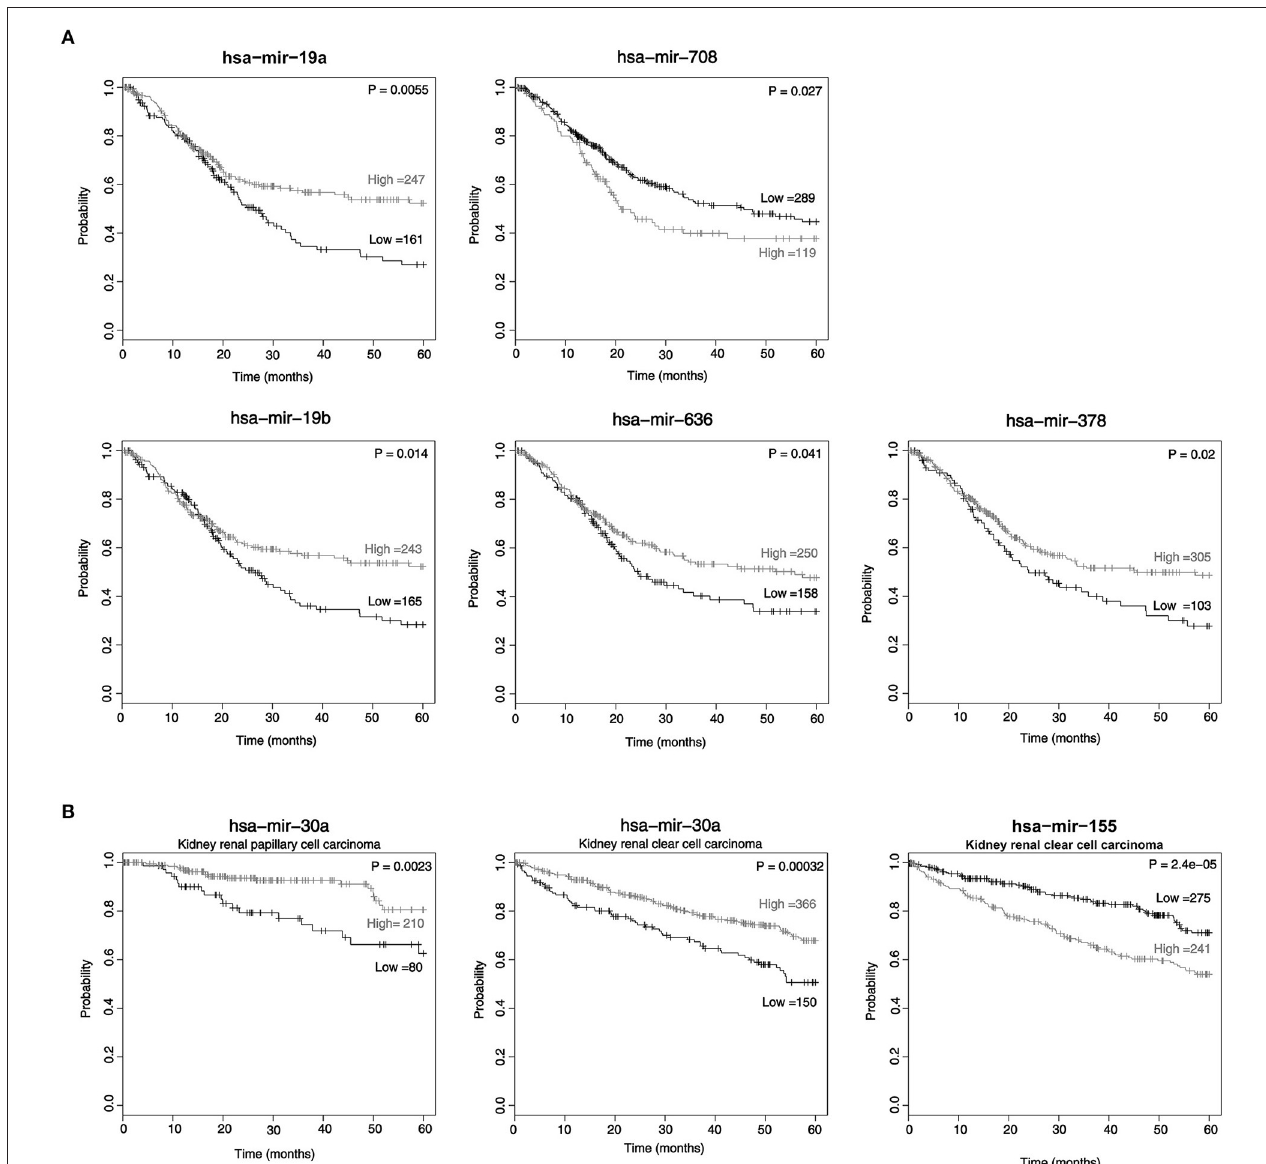
FIGURE 3 | The expression of miRNAs in cancer tissue is associated with survival. The Kaplan-Meier survival curve of patients: low miRNA expression vs. high miRNA expression according to the automatic best cutoff from the database. The statistical significance of the difference in bladder cancer (A) and kidney renal papillary cell carcinoma and kidney renal clear cell carcinoma (B) are